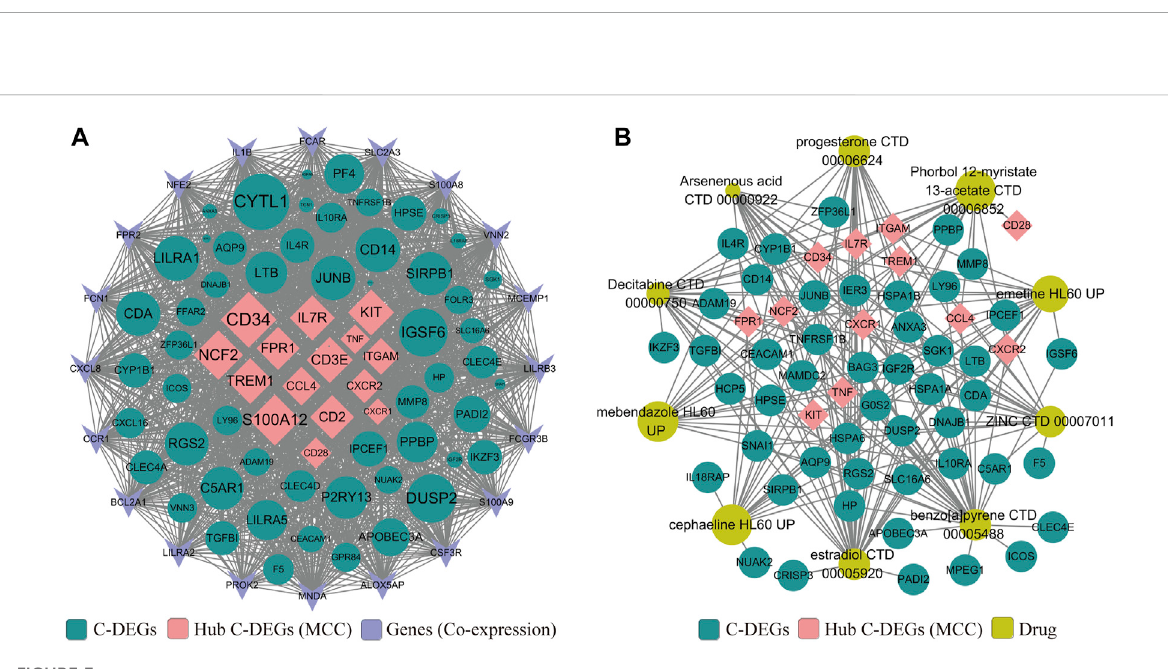
FIGURE 3 ConstructionofPPI (A) andprotein – druginteraction (B) networksonthoseidenti fi edC-DEGsbyGeneMANIA,STRING,Enrichr,andCytoscape. Pink represents core C-DEGs that were identi fi ed by the MCC algorithm of the Cytoscape plugin (cytoHubba), green represents other C-DEGs, sky blue represents co-expressed genes identi fi ed by GeneMANIA, and ginger represents candidate drugs obtained in DSigDB via the Enrichr